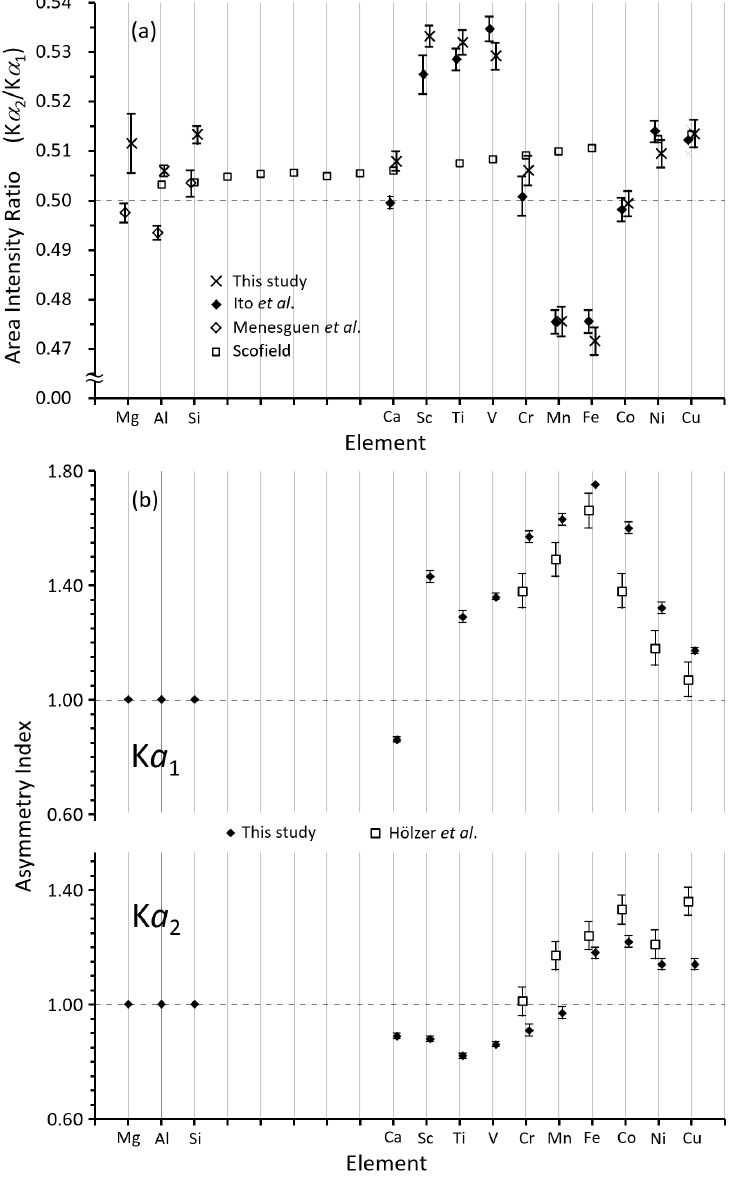
Figure 2. ( a ) K α 2 / K α 1 intensity ratio of the elements Mg to Cu. Cross marks are the present experimental data, open square are Scofield’s [3] theoretical data, solid diamonds [6], open diamonds in Mg, Al, and Si [23]. The K α 1,2 spectral lines in each of the elements were measured using a high-resolution double-crystal X-ray spectrometer [6,20,24]. ( b ) Asymmetry index of K α 1,2 lines for the elements Mg to Cu are shown together with the data by Hölzer et al. [9]. Asymmetric indices are obtained with an asymmetric Lorentzian fitting analysis [20,21]. See the text for